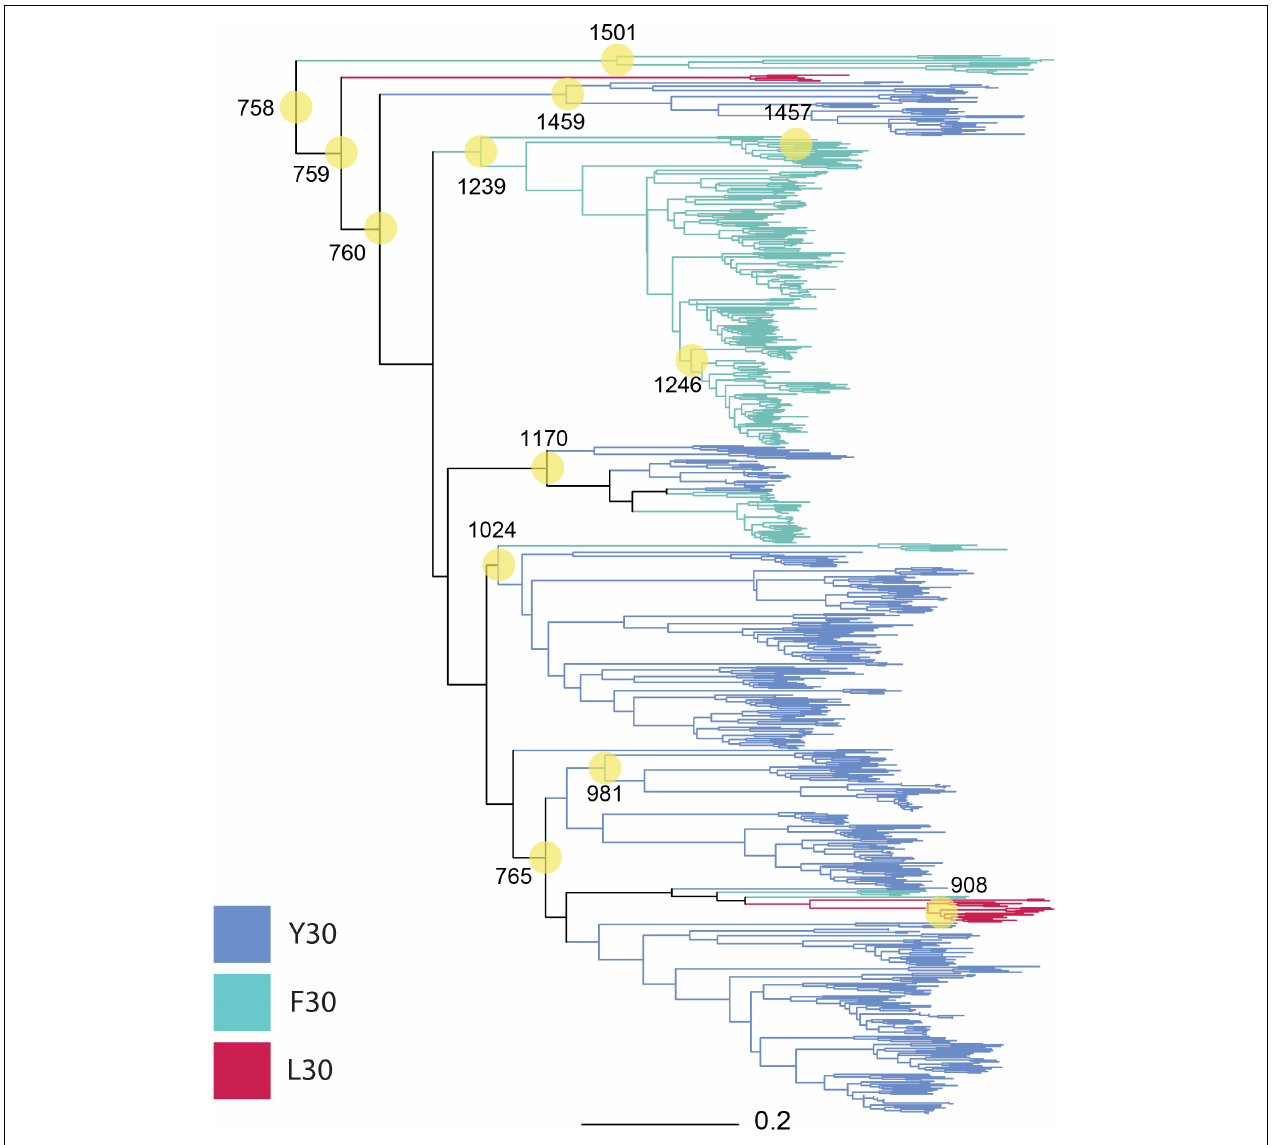
FIGURE 1 | Phylogeny of 757 MotB homologs. MotB homologs selected via EBI-EST and restricted to FAD/YAD/LAD at residues 30–32 ( E. coli MotB). ASRs were calculated for every node, with those selected for engineering and resurrection indicated (yellow circles, numbering from root beginning at 758). Tree branches were colored based on sequence identity at residue 30 F/Y/L in the contemporary strain where conserved (Y30: blue, F30: green, L30: red, mixture: black).